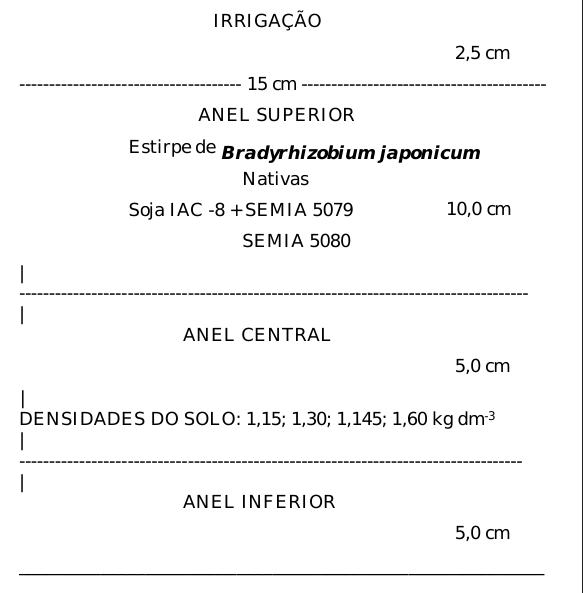
Figura 1. Esquema do vaso formado pela sobrepo- sição de três anéis de